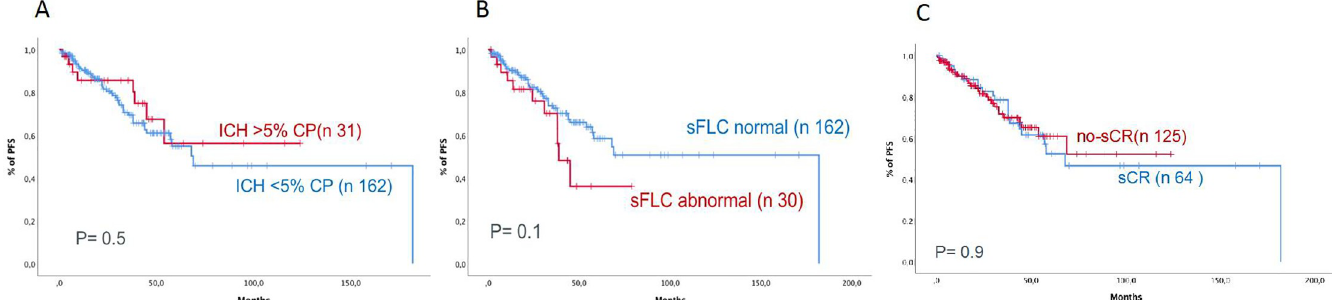
Fig 1. Progression-free survival of patients based on (A) immunohistochemistry, (B) normal serum free light chain ratio, and (C) stringent complete response.